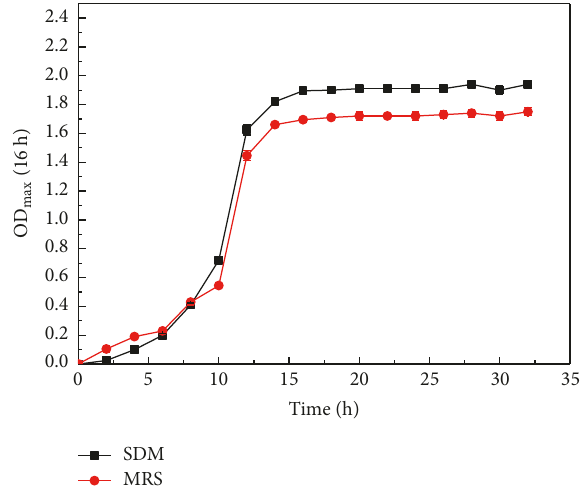
Figure 6: Growth of Enterococcus faecium Y31 on MRS and SDM.